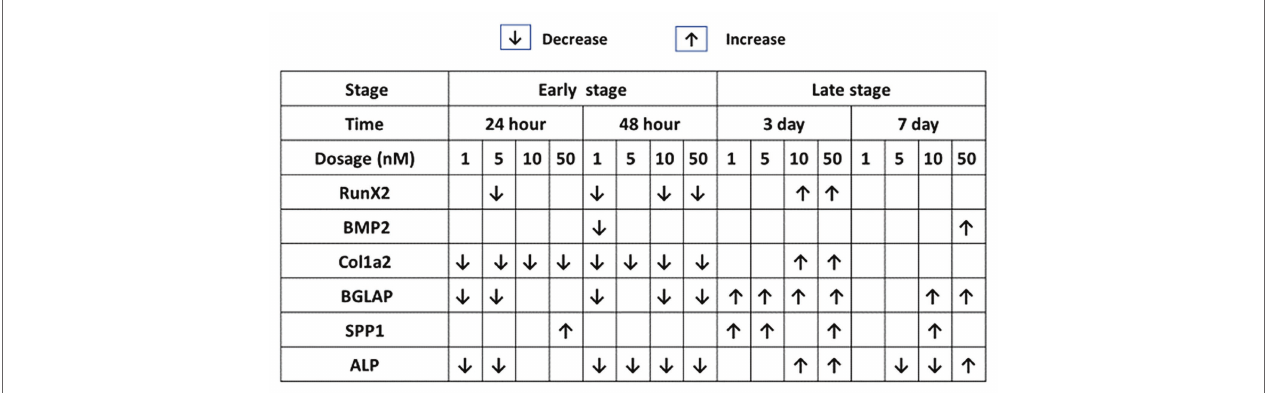
FIGURE 4 | Effects of 1,25OHD on chicken osteoblasts key osteogenic gene expression by using qRT-PCR. Cells were treated with control media, osteogenesis media, or osteogenesis media with 1, 5, 10, or 50 nM 1,25OHD. The results are summarized in the figure: the down-arrows indicate the genes are down-regulated by 1,25OHD treatment compare to OM; the up-arrows indicate the genes are upregulated by 1,25OHD treatment compare to OM (Value means ± SEM, three